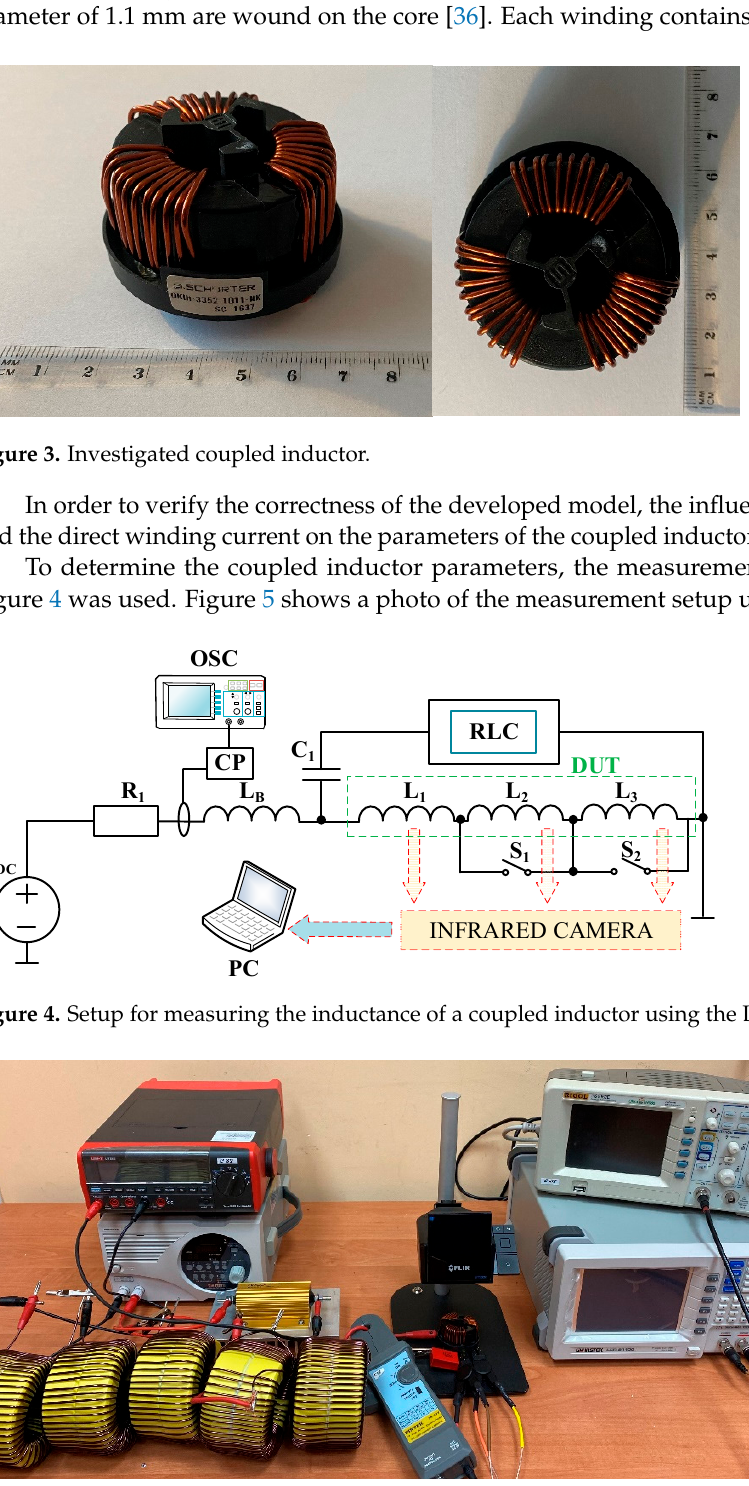
Figure 5. Photo of the setup for measuring the inductance of the inductor.